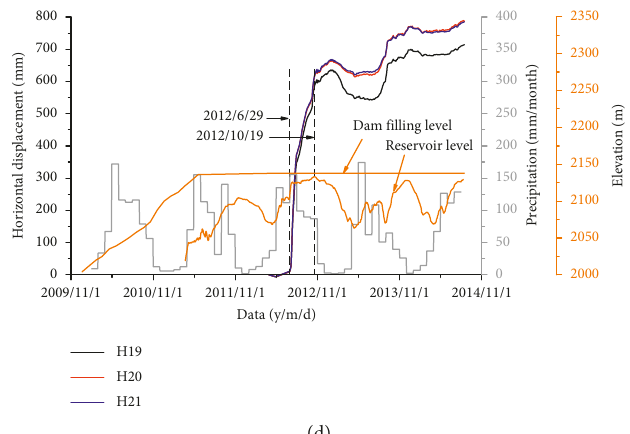
Figure 5: Evolution of horizontal displacements with time in the Maoergai dam. (a) EL. 2031m; (b) EL. 2048m; (c) EL. 2078m; (d) EL.